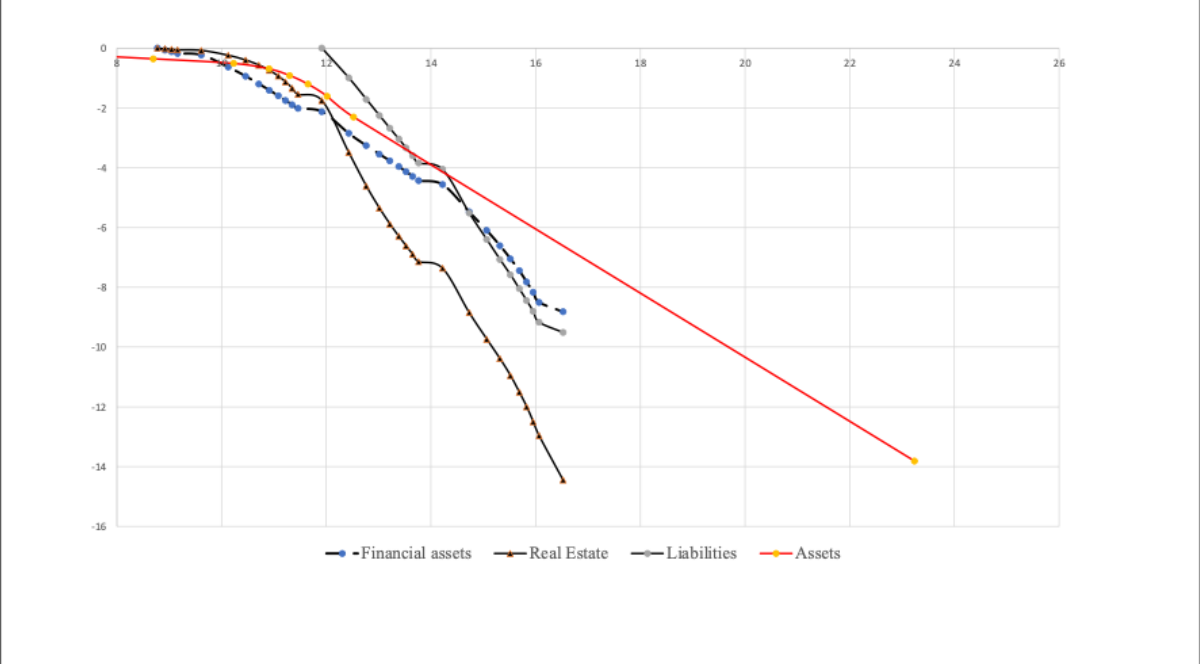
Figure 9. Distribution of the components of